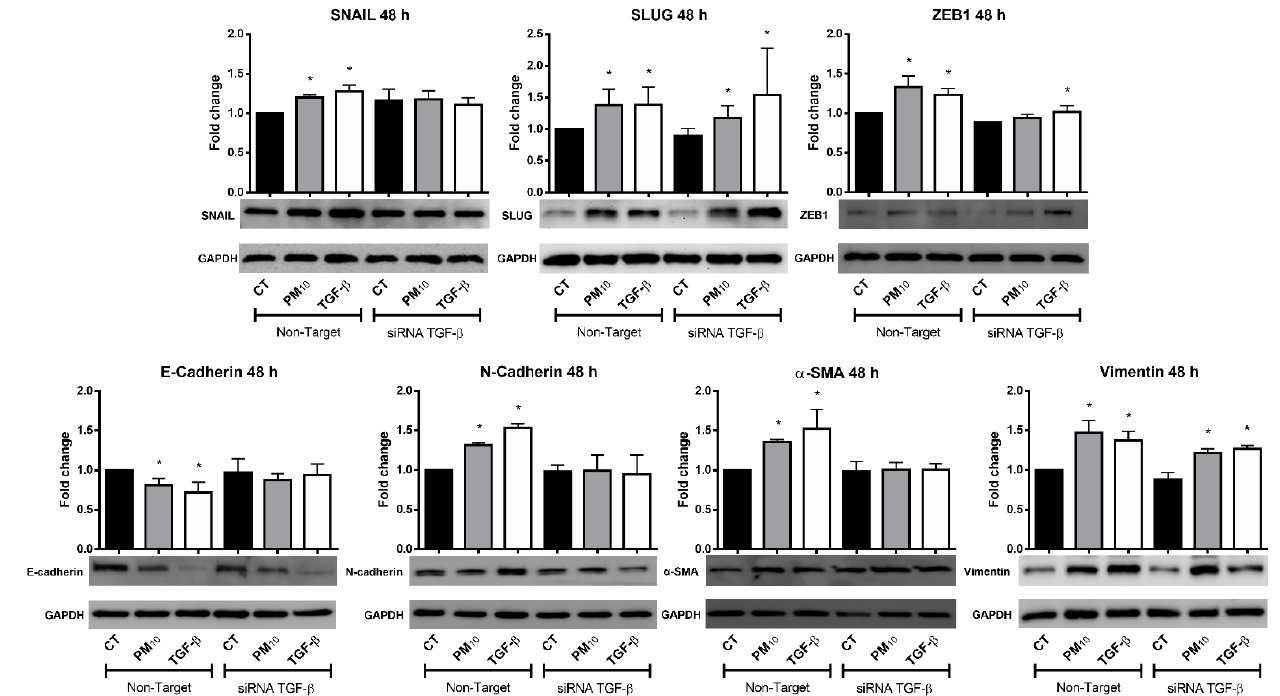
Figure 3. Particulate matter PM 10 increases the protein levels of EMT markers in A549 cells after 48 h of treatment. Particulate matter exposure increases the protein levels of Snail, Slug, ZEB1, N-cadherin, α -SMA, and vimentin, and decreases the protein levels of E-cadherin, while TGF-β treatment increases the protein levels of Snail, Slug, ZEB1, N-cadherin, α -SMA, and vimentin, and decreases the protein levels of E-cadherin in cultures of A549 cells transfected with non-targeting siRNA. These effects are prevented by TGFB1 siRNAs only in Slug, ZEB1, N-cadherin, α -SMA, and vimentin. Cells were exposed to PM 10 (10 µ g/cm 2 ) and TGF- β (5 ng/mL) for 48 h. The quantitative results were expressed after normalization using GAPDH as a loading control. Data are reported as the means ± SD of three independent experiments. The images are representative of the data obtained. (*) indicates statistically differences between treatments. Densitometry was performed using arbitrary units p < 0.05.